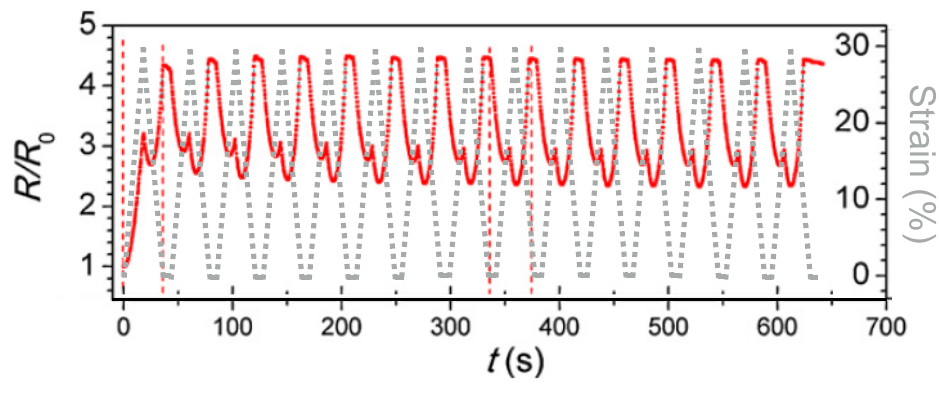
Figure 26. Strain sensing behaviour of coated yarn with 2 wt% of CNT upon cyclic loading at 30% strain amplitudes. Adapted from Zhang et al.